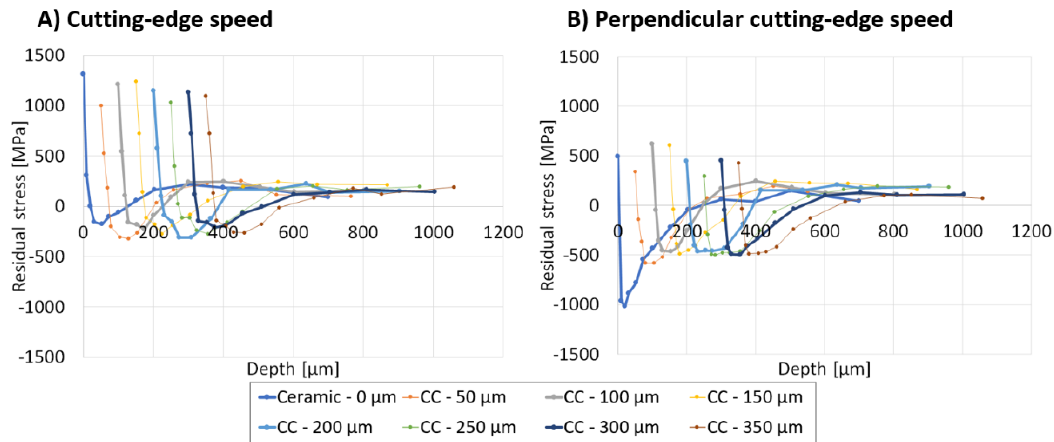
Figure 9. Residual stresses for each milling steps for the centre of the slot.